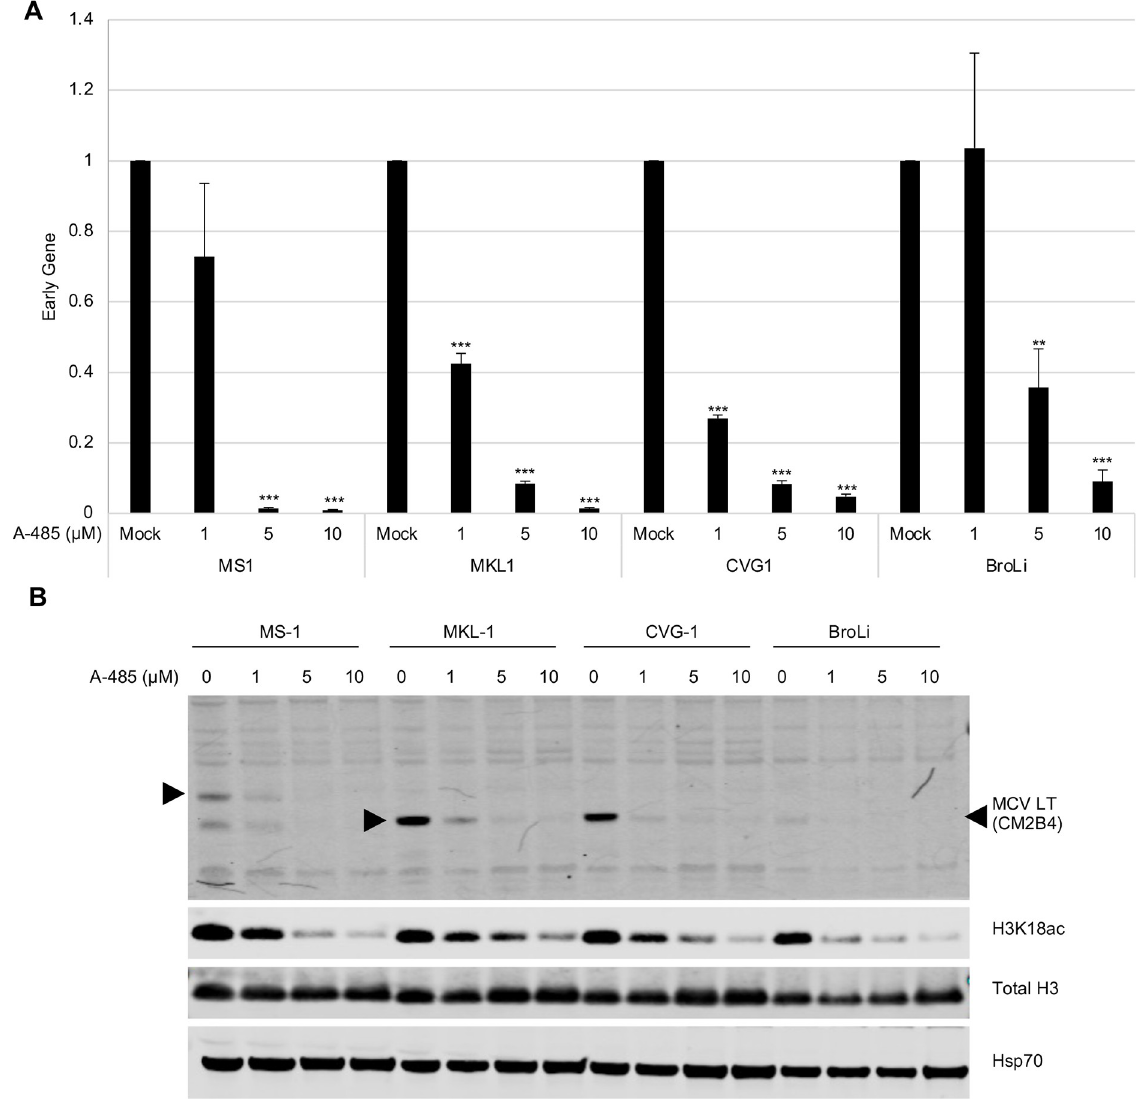
Fig 9. CBP regulates T antigen expression in MCV-positive MCC. (A) CBP/p300 inhibitor, A-485, significantly decreases early gene expression. MCV-positive CVG-1, MKL-1, MS-1, and BroLi cell lines were treated with various concentrations of A-485 and harvested at day 4. Total extracted RNA was subjected to qRT-PCR analysis by the 2 - ΔΔ Ct method using the PanT primer with 18S ribosomal RNA for normalization. Relative mRNA expression to the mock-treated sample is shown for each respective cell line. Error bars indicate SD. Unpaired T-test was used for statistical analysis. � , P < 0.05; �� , P < 0.01; ��� , P < 0.001. (B) Corresponding immunoblots for qRT-PCR shown in Fig 9A. MCV LT was detected by CM2B4. H3K18ac and total H3 were detected to confirm A-485 activity. HSP70 was used as a loading